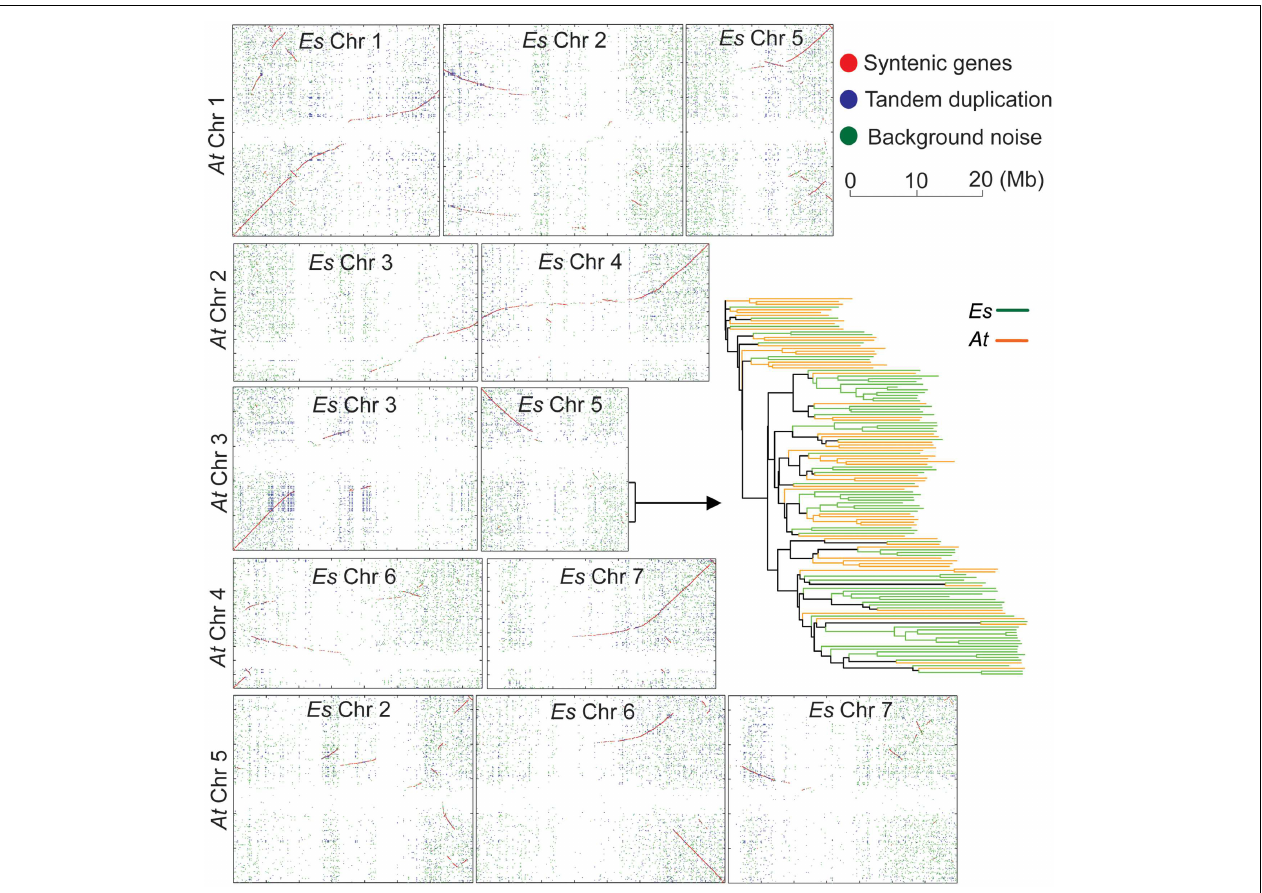
FIGURE 5 | Chromosome-scale synteny between A. thaliana and E. salsugineum. Each dot represents a pair of orthologs between A. thaliana and E. salsugineum . Red dots, macro-synteny orthologs. Blue dots, tandemly duplicated orthologs. Green dots, background